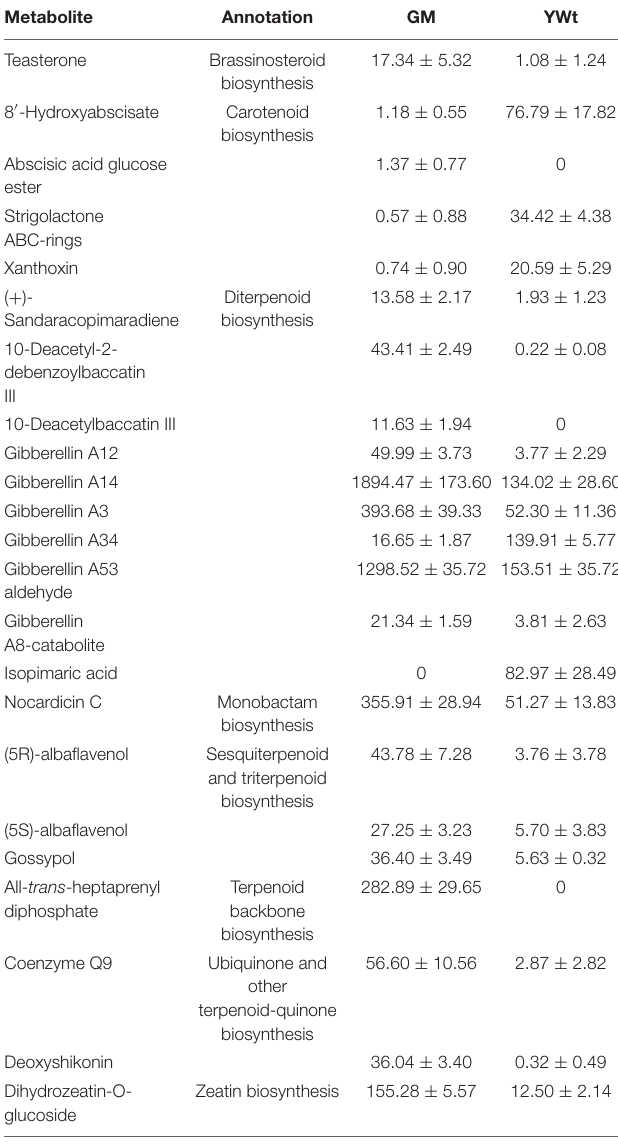
TABLE 2 | Metabolites in terpenoids and